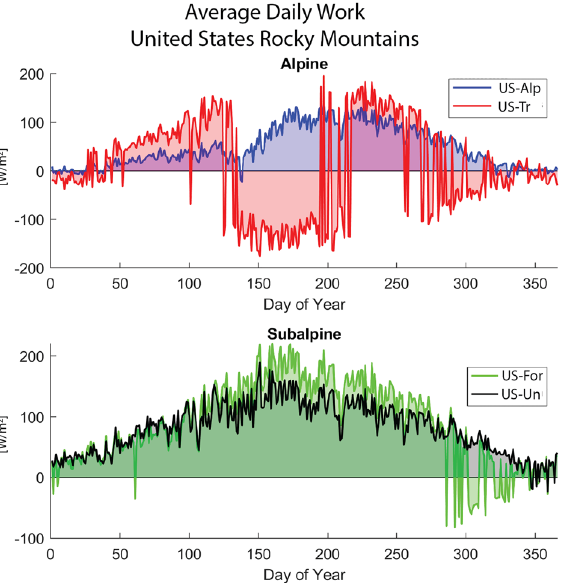
Figure 4. Average daily time series of work for the entire study period (2008–2013) for scenarios in the United States Rocky Mountains. The top panel demonstrates the prolonged negative work (i.e., heat transport in the opposite direction of the temperature gradient) associated with snowmelt and winter temperature inversions of the simulated alpine forest ( red ; US-Tr), indicating that this counterfactual is thermodynamically infeasible. The existing alpine and subalpine vegetation ( blue , US-Alp & green , US-For) generally only experience negative work during snowmelt conditions. The subalpine forest ( green ; US-For) experiences negative work sporadically for short durations during the winter; these instances are a function of snowmelt as well since the snowpack does not persist throughout the winter at this site (see Fig.